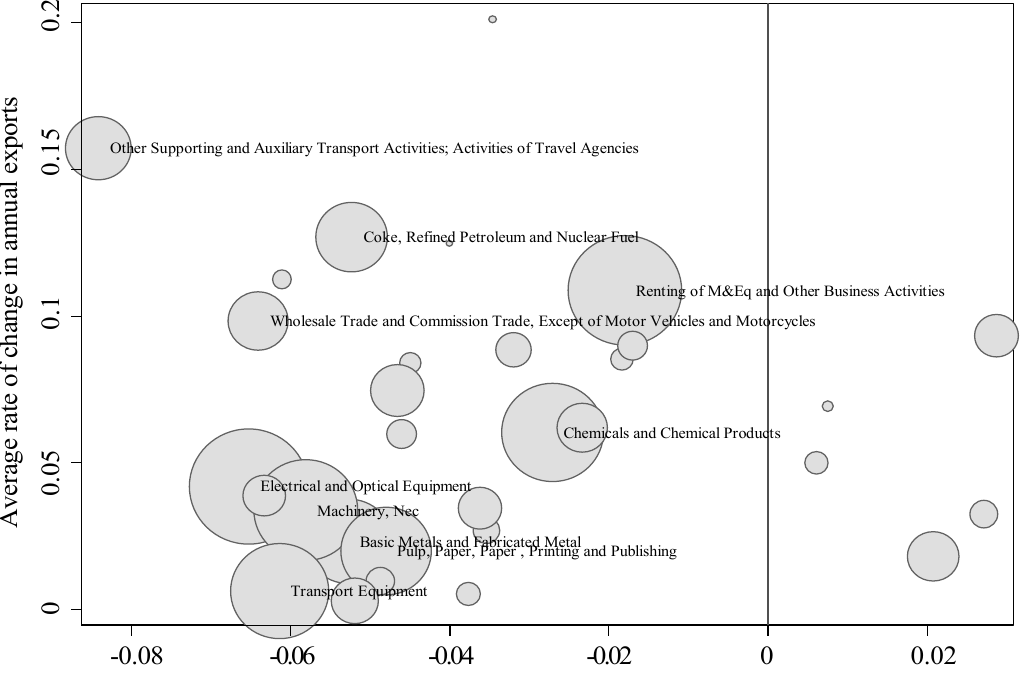
Figure 8. Average annual rate of change in carbon intensity versus change in annual export volumes. Note: The size of the circle indicates the relative share of the sector in total exports in 2009. Area in the left-hand side of the graph refers to the most desirable situation with increasing exports in sectors with falling carbon intensity. Area on the right-hand side denotes the opposite, suboptimal situation, with increasing exports from sectors with growing carbon